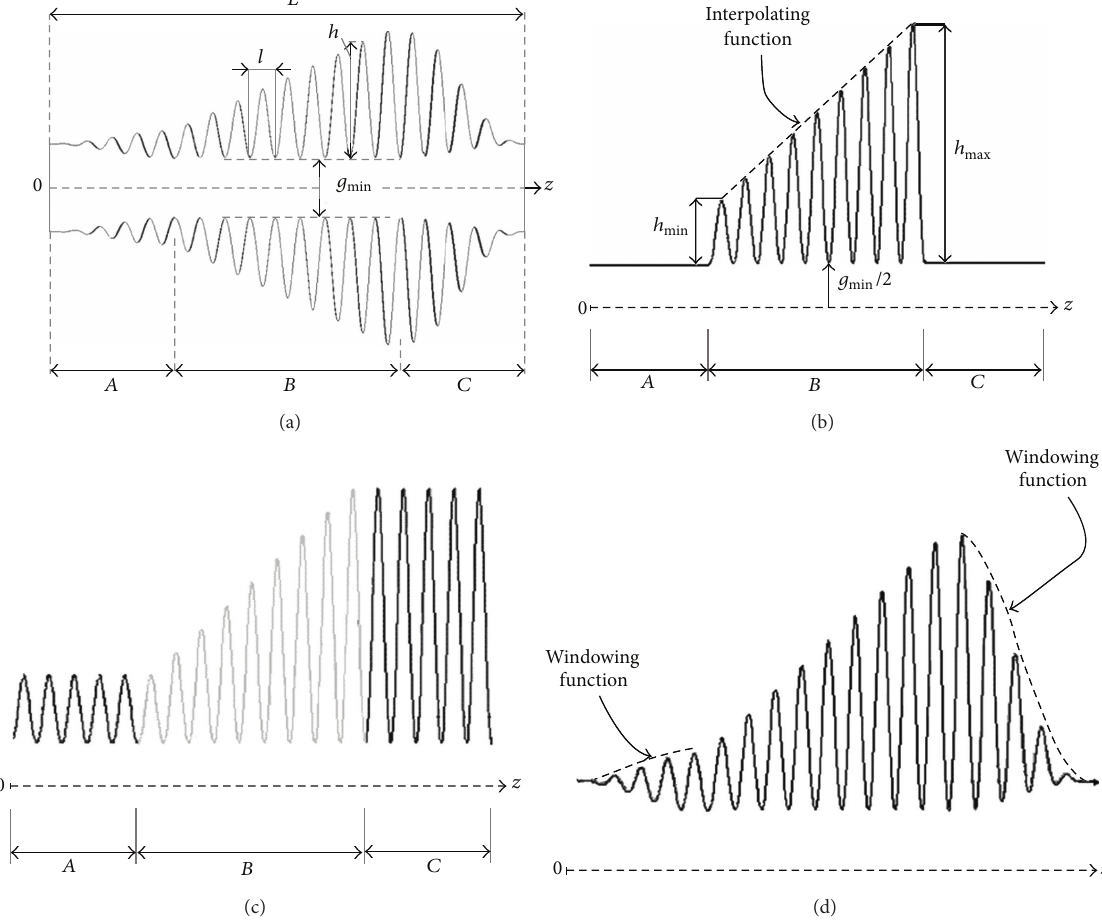
Figure 9: Schematics showing the design process of novel high-power spurious-free low-pass waveguide filters: (a) sketch showing the final filter profile and its physical parameters; (b) shaping of section 𝐵 ( 𝑔 min , ℎ min and ℎ max ); (c) new bandstop elements added to define sections 𝐴 and 𝐶 ; and (d) windowing applied to sections 𝐴 and 𝐶